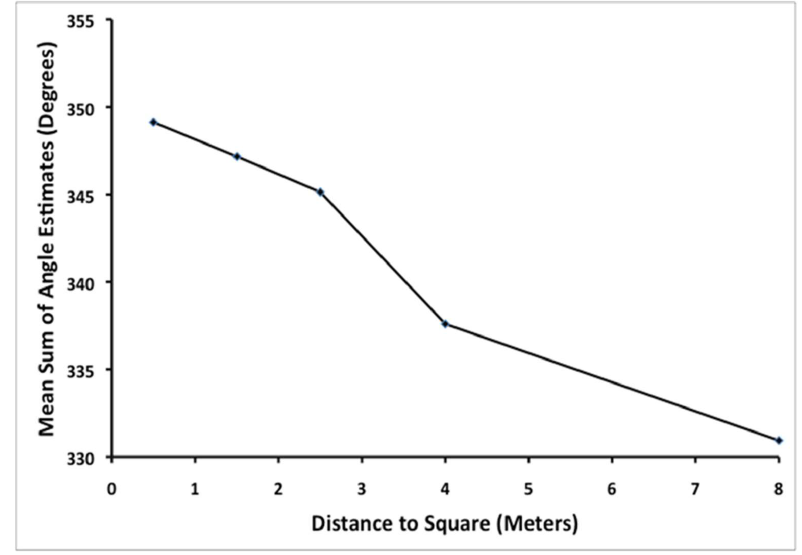
Figure 3. Mean sum of the angle estimates (in degrees) for each square as a function of distance (in meters) to the square from the observer to the square in Experiment 1. (in meters) to the square from the observer to the square in Experiment